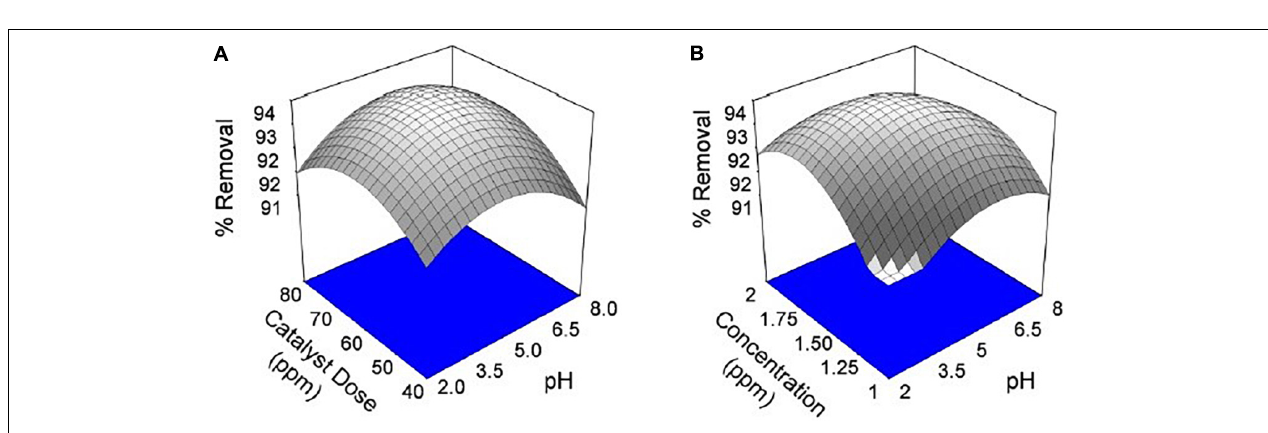
FIGURE 6 | Effect of chromium by using seed bio-sorbent of Mango (M) and Jackfruit (JF): (A) adsorbent dose and pH and (B) concentration and pH of solution.